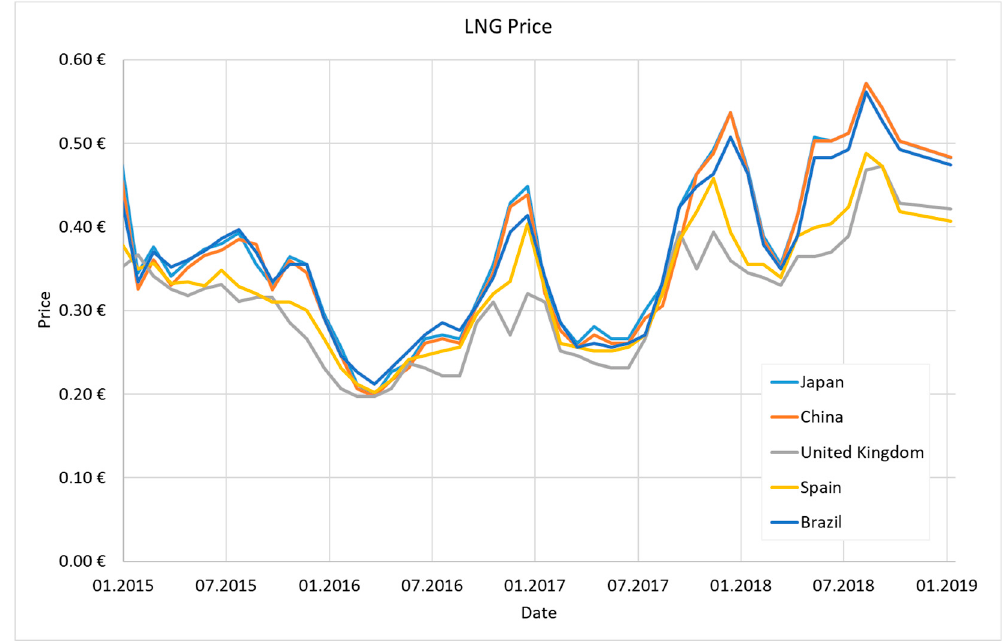
Figure 3. LNG prices in previous years [61].